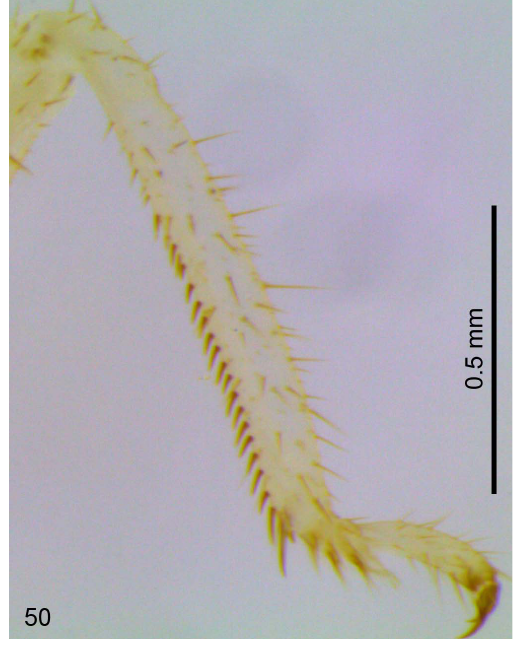
Fig 50. Foretibia of Cornitermes cumulans worker. Certain species or groups of species of Syntermitinae show marked synapomorphic characteristics of the internal anatomy. The gizzard and crop generally follow the basic plan for the Termitidae (as described by Noirot, 2001), but Ibitermes curupira , Embiratermes robustus , and the species of Mapinguaritermes show a very characteristic ornamentation of spines at the base of the first-order pulvilli (Fig